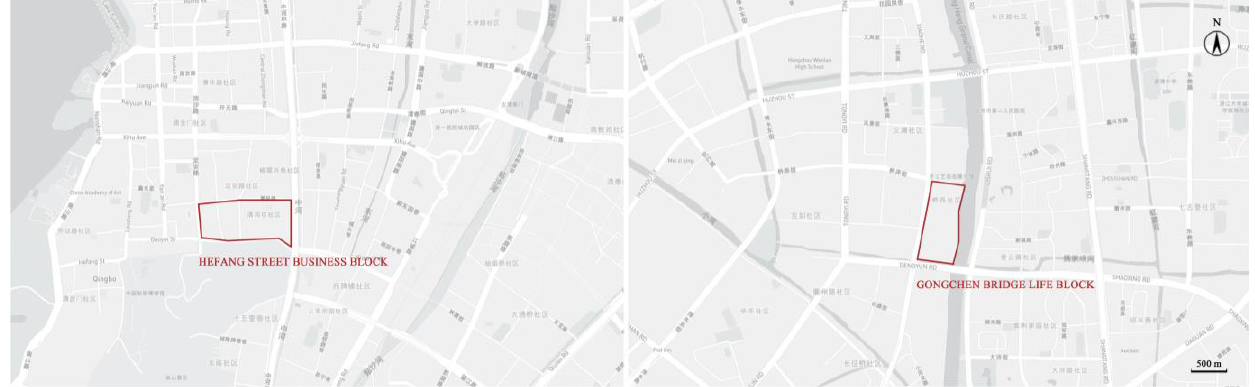
Figure 6. Maps of Hefang Street business block and Gongchen Bridge life block (according to Baidu map).